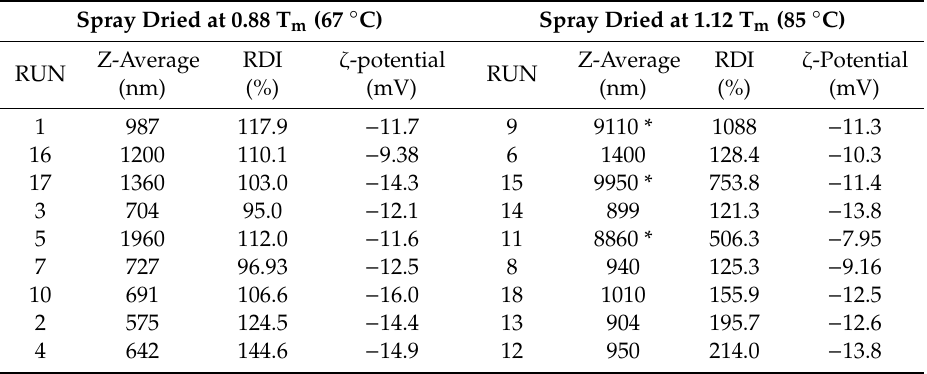
Table 5. Particle size, redispersion index, and ζ -potential of IBU before and after